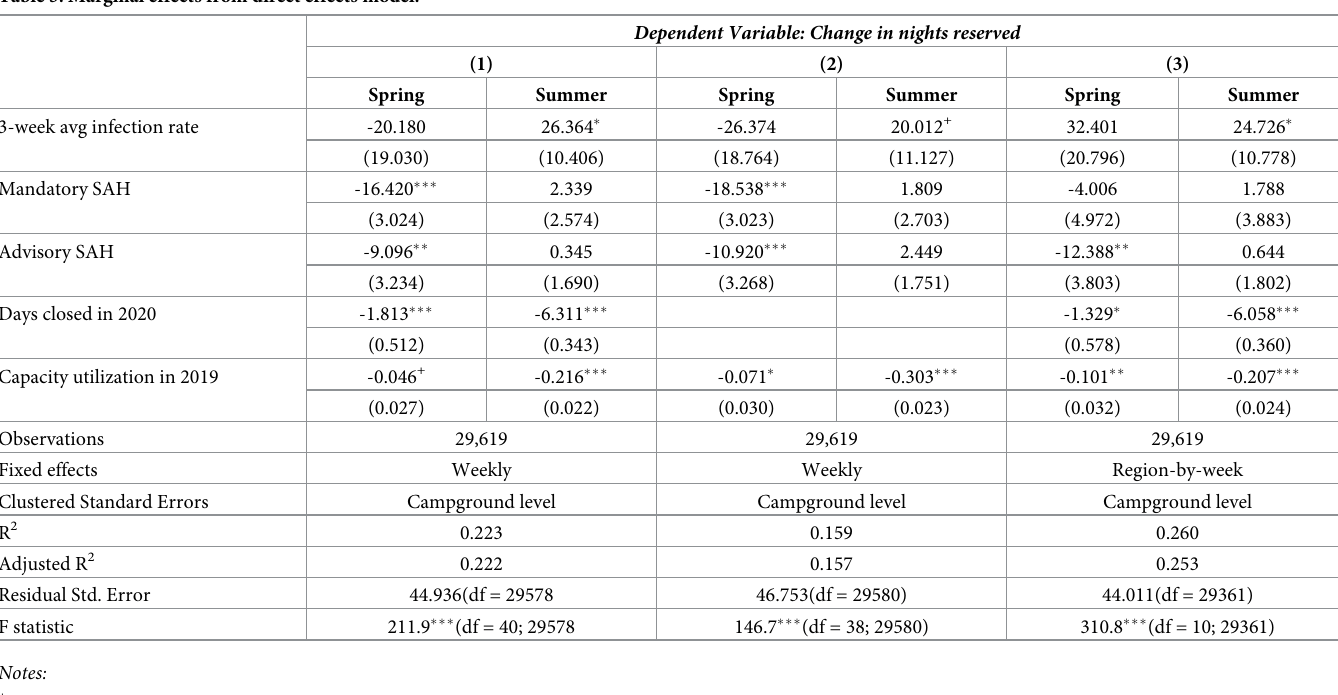
Table 3. Marginal effects from direct effects